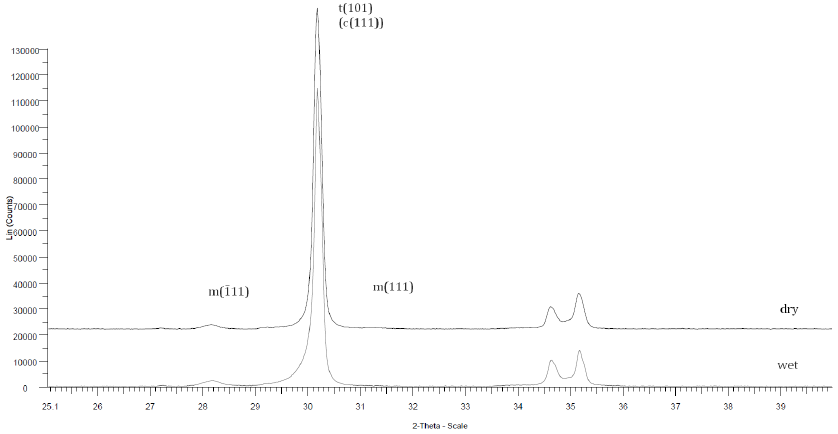
Figure 4. X ‐ ray diffraction pattern example: Z, biaxial dry and wet. Figure 4. X-ray diffraction pattern example: Z, biaxial dry and